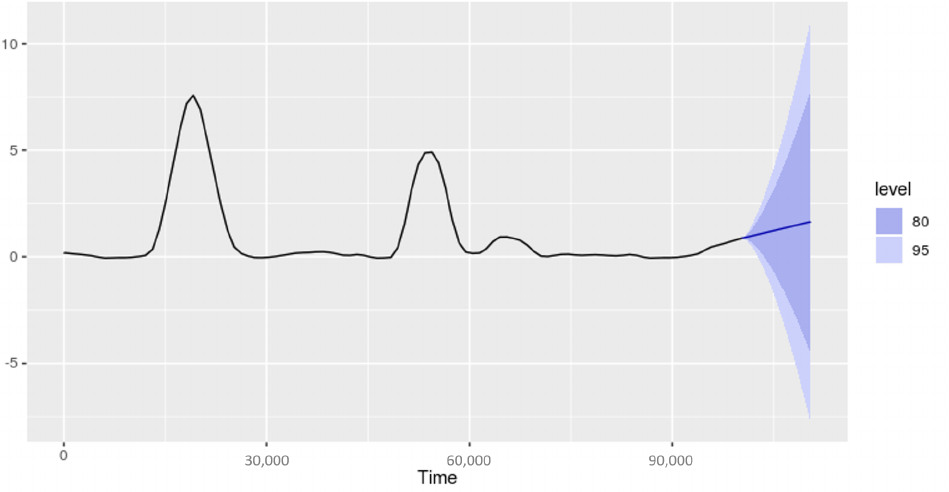
Figure 10. Active Energy